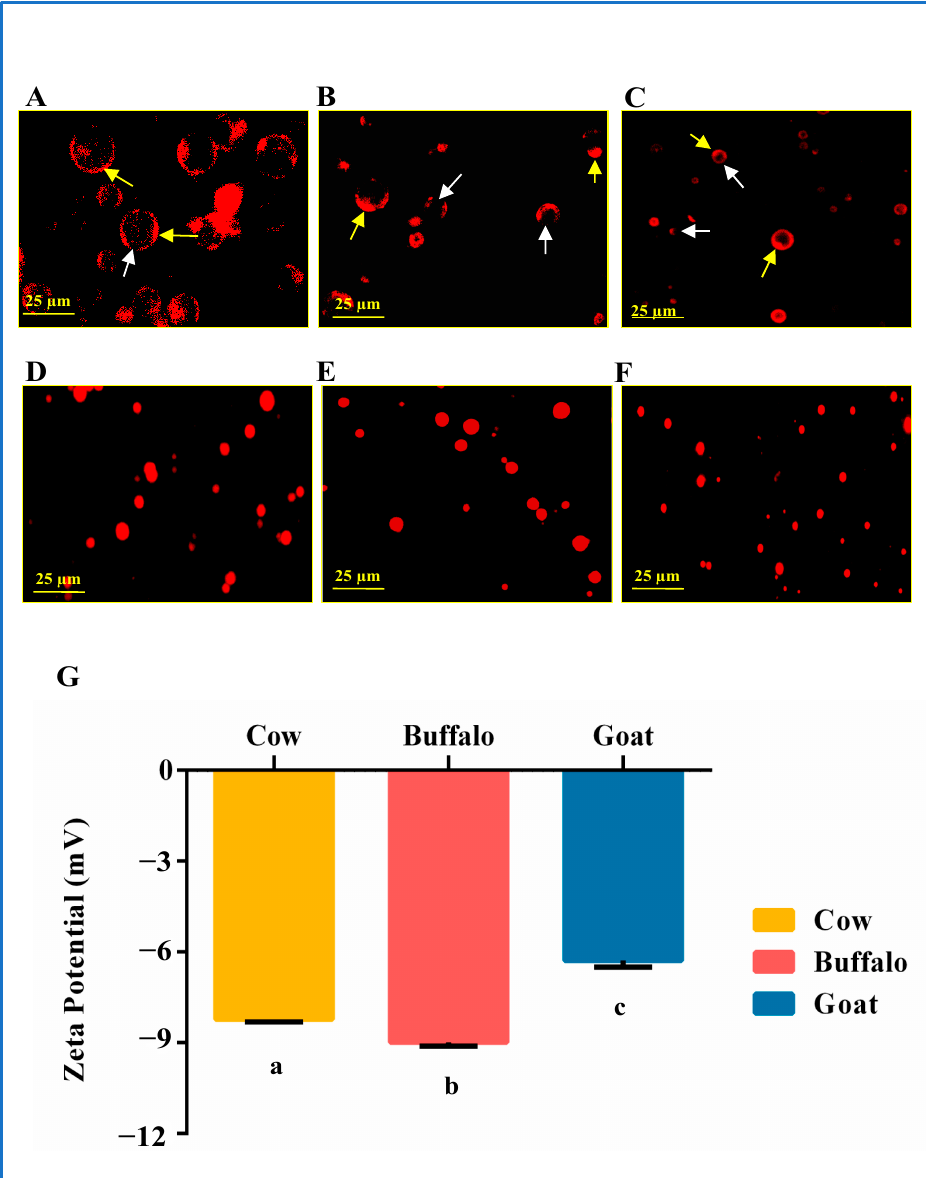
Figure 5. Microstructure analysis of fat globules stained with phosphatidylethanolamine-lissamine rhodamine (red) in ( A ) cow, ( B ) water buffalo, and ( C ) goat milk; Triglycerides were stained with the Nile red in fat globules of ( D ) cow, ( E ) water buffalo and ( F ) goat; ( G ) Zeta potential measurements between the animal groups. Representative image of three independent biological samples performed in triplicate. Different letters indicate a significant difference ( p ≤ 0.0001). Scale bar = 25 µ m.